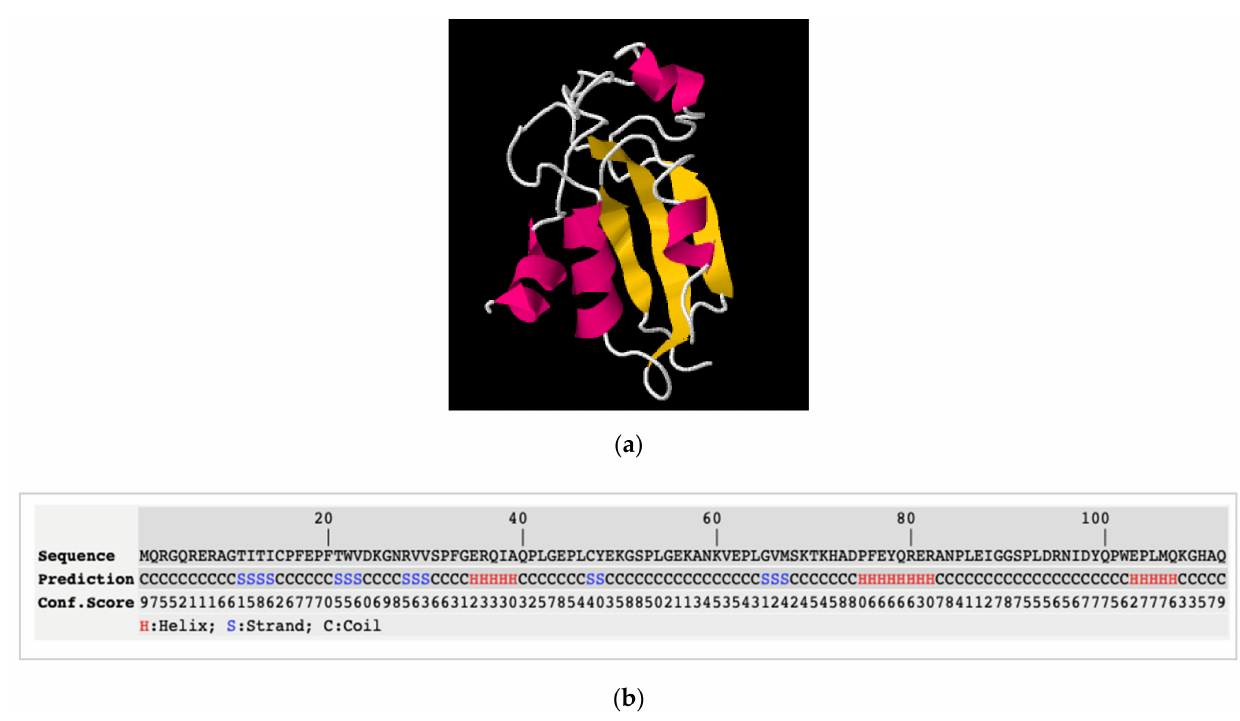
Figure 3. Predicted secondary and tertiary structure of sequence Round 3.3 by I-TASSER. ( a ) Three- dimensional tertiary structure cartoon model. In pink α -helices, in yellow β -sheets and in white coil regions. ( b ) Secondary predicted structure. H: α -helices; S: β -sheets; C: coil regions based on in silico digestion of initial designed sequences for primary structure. One letter amino